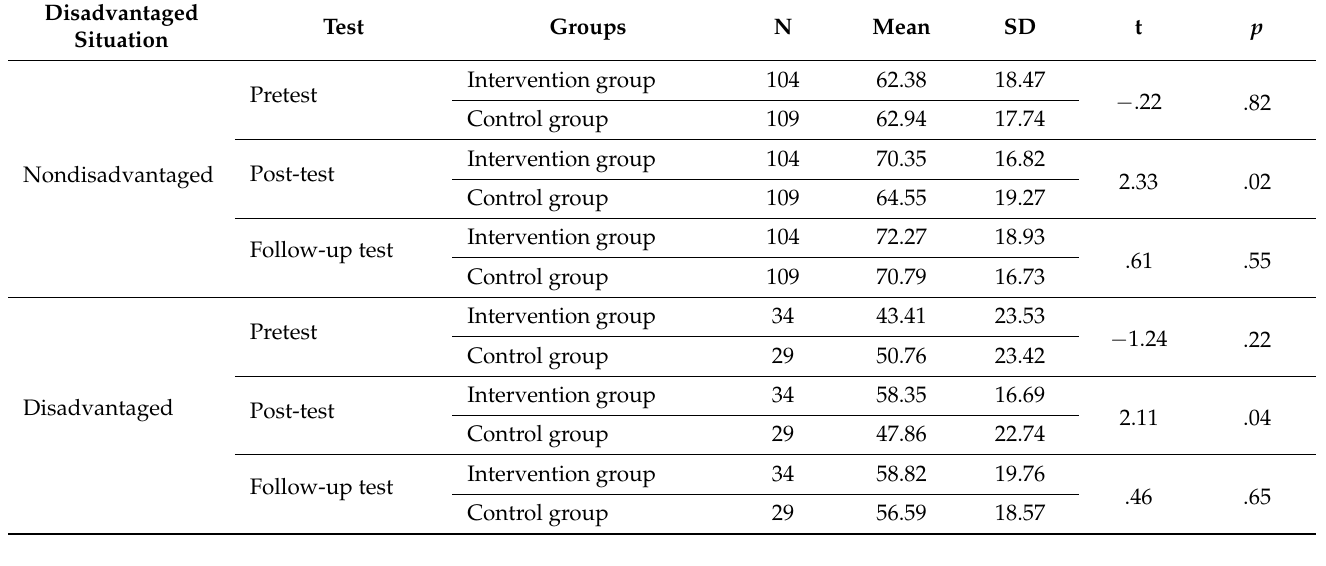
Table 4. The performance of the students in the intervention and control groups according to the three skill groups on the pre-, post-, and follow-up tests with respect to disadvantage.